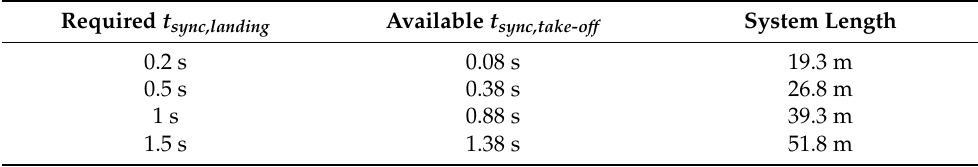
Table 12. The system length with different synchronisation times. Required t sync,landing Available t